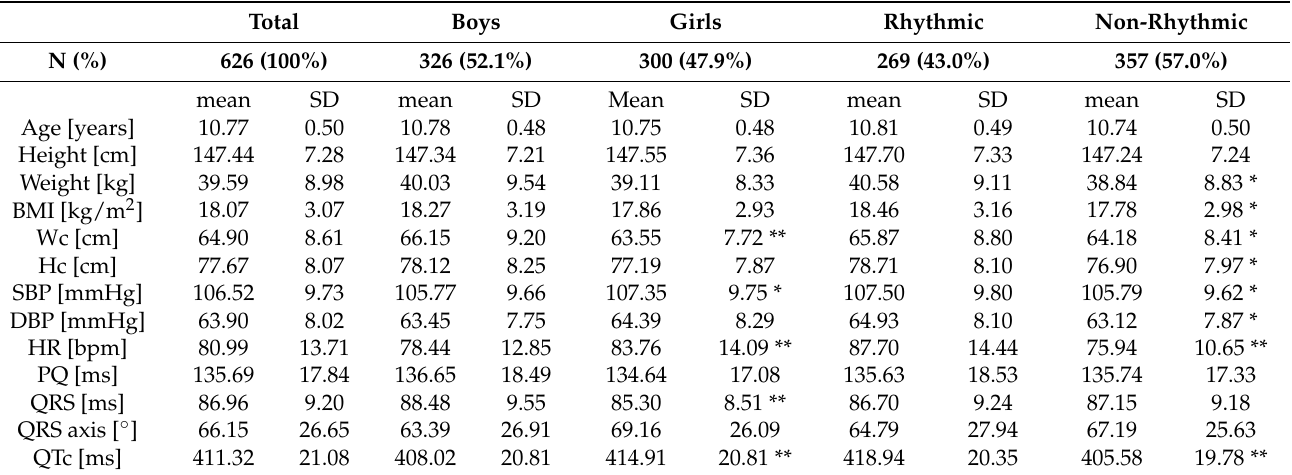
Table 1. Descriptive statistics of the study